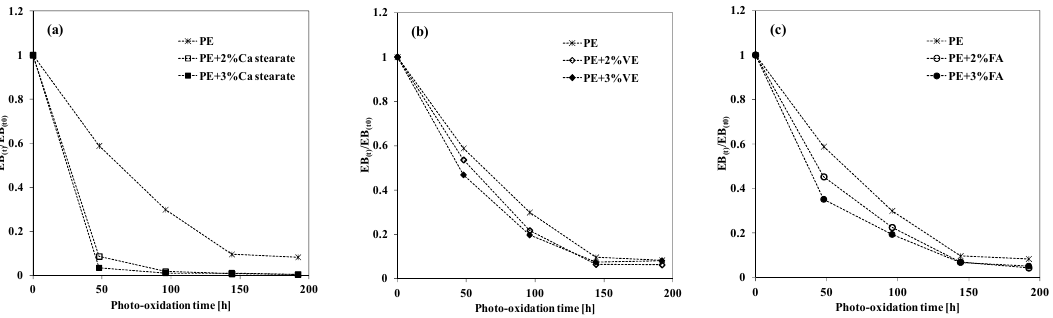
Figure 5. Dimensionless elongational at break EB(t)/EB(t 0 ) of neat PE and PE containing different compounds as a function of the photo-oxidation time. ( a ) Ca stearate; ( b ) Vitamin E; ( c ) Ferulic Acid